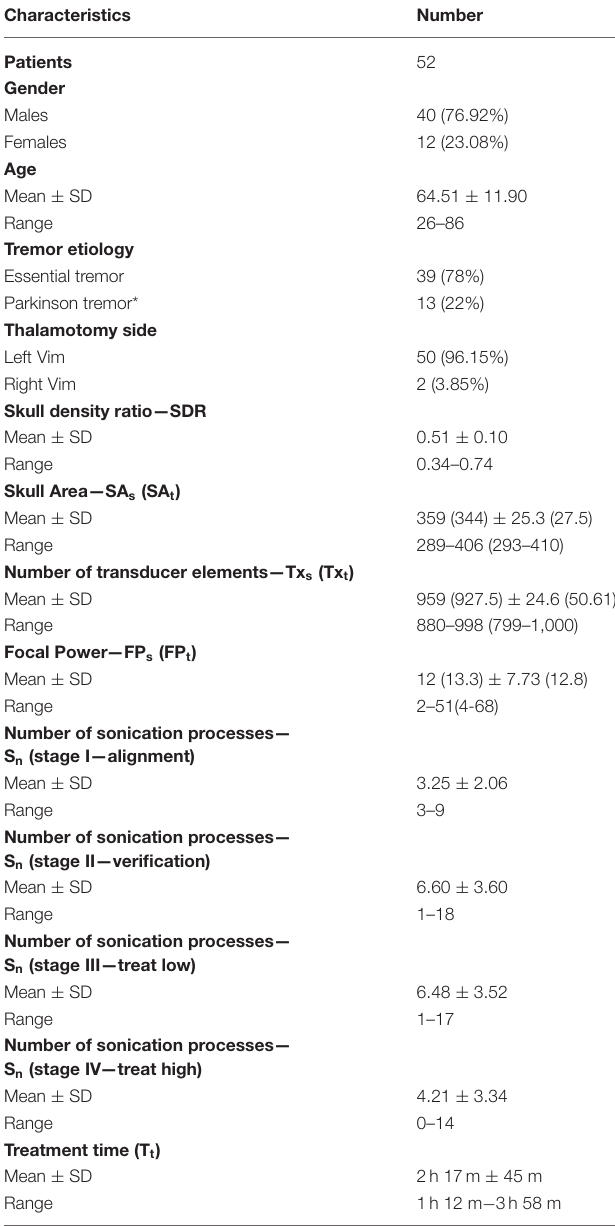
TABLE 1 | Summary of patient demographics and treatment data included in the final analysis.